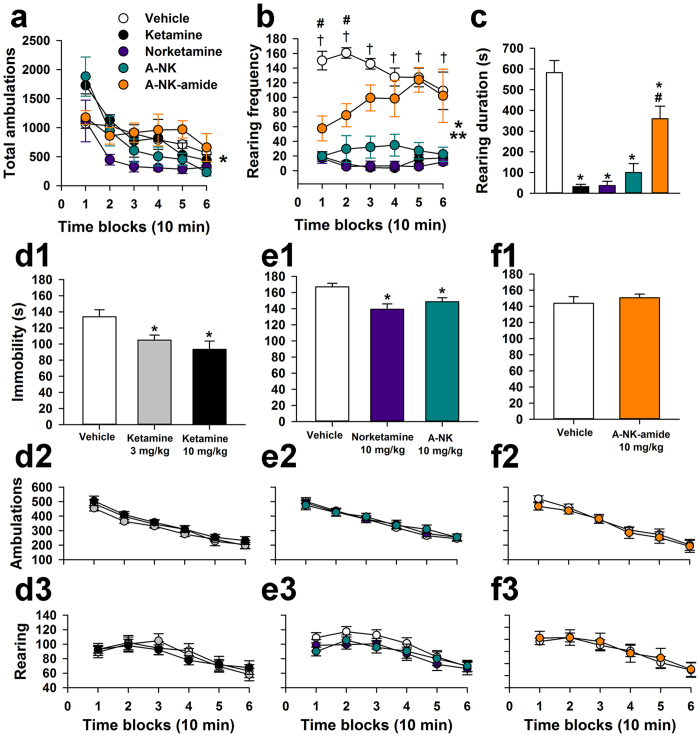
Ketamine, norketamine and A-NK, but not A-NK-amide, exhibit strong psychoactivity.(a) Ambulatory activity following i.p. drug injection at 50 mg/kg (ketamine) or 100 mg/kg (other compounds). rmANOVA showed a significant Treatment x Time Blocks interaction, [F(20,100) = 2.57, *p = 0.004], but additional contrasts showed no consistent drug induced change relative to vehicle controls (n = 5 animals per condition). (b) All drug treatments decreased vertical rearing frequency [Treatment effect: F(4,20) = 30.10, **p < 0.00005; Treatment x Time Blocks interaction: F(20,100) = 2.42, *p = 0.009], although the effect was smaller and more short-lived for A-NK-amide. Specifically, rearing was reduced (beyond Bonferroni correction) in the ketamine, norketamine, and A-NK groups for all time blocks (†p < 0.008), but A-NK-amide reduced rearing for only the first two time blocks (#p < 0.008). (c) Ketamine and analogues also decreased average rearing duration in the same test session [Treatment effect: F(4,20) = 30.51, p < 0.00005]. Durations were significantly decreased in each of the drug treatment groups relative to vehicle controls (*p < 0.002). However, rearing duration in the A-NK-amide group was significantly greater than duration in the other drug groups (#p < 0.0005). For A-C, n = 5 mice per condition. (d1) Ketamine reduced immobility time measured during the FST in mice 3 hours after administration of the indicated concentrations of ketamine (Treatment effect: p = 0.005). Both 3 mg/kg and 10 mg/kg significantly reduced immobility time (*p = 0.021 and 0.002, respectively, n = 20 mice per condition). (d2,d3) In separate experiments using control animals from the FST test, ambulatory activity and rearing behavior were evaluated 3 hr following following drug injection (Symbol colors as in D1, n = 13 mice per condition). No effect of drug on locomotion or rearing was detected. (e1–e3) Norketamine and A-NK (10 mg/kg) also significantly reduced immobility time in the FST (Treatment effect: p = 0.002; *p = 0.0005 and 0.019, respectively; n = 32–34 mice per condition), but had no effect on ambulations or rearing (n = 17–27). (f1–f3) A-NK-amide (10 mg/kg) did not significantly alter immobility time compared with cohort-matched controls (n = 25 per condition). General ambulatory activity and rearing were unaffected (n = 12 per condition). In D1 and E1 asterisks indicate significantly different from vehicle control in pairwise comparisons following ANOVA.